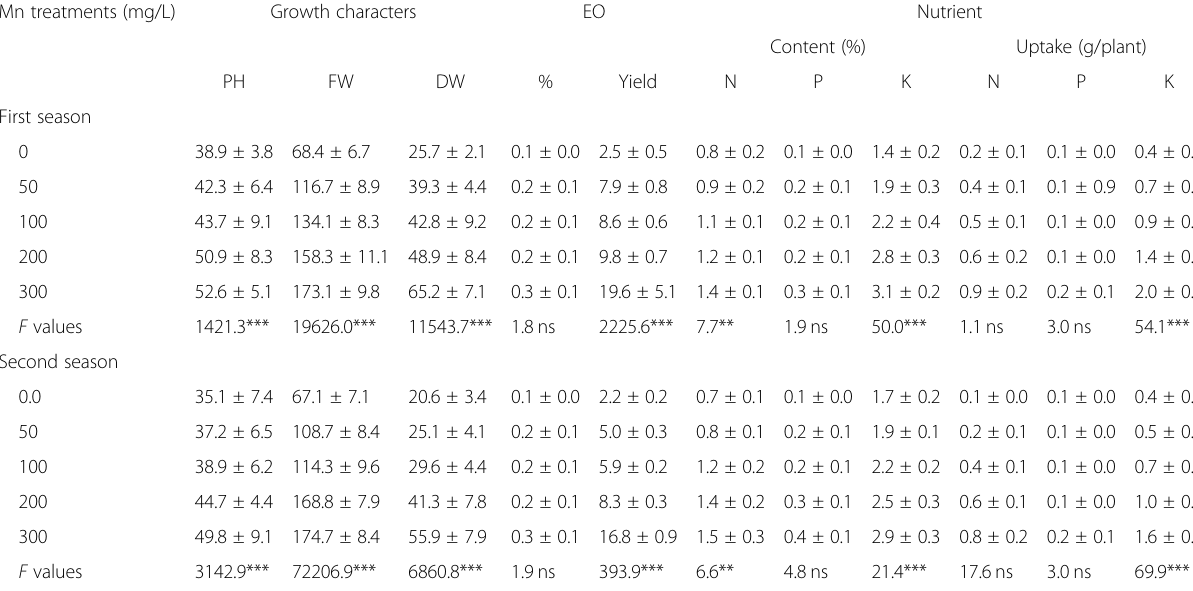
Table 5 Effect of Mn treatments on growth and chemical content Mn treatments (mg/L) Growth